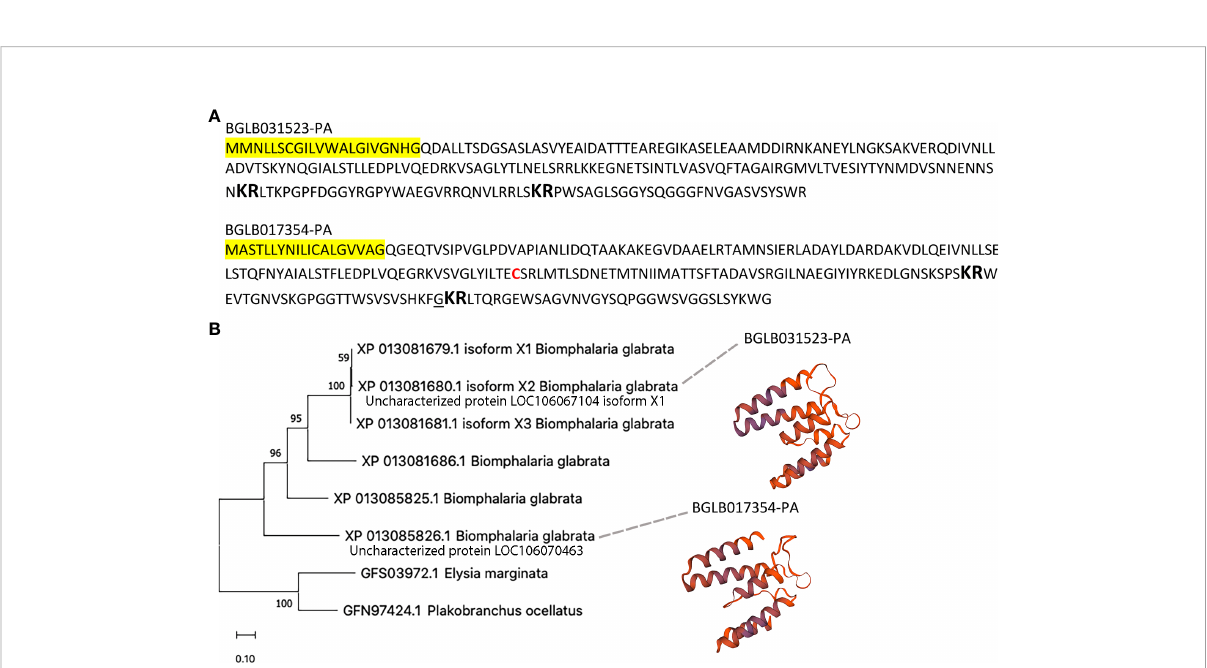
FIGURE 4 Characterisation of S. mansoni attractant candidates uncharacterised proteins LOC106067104 isoform X1 and LOC106070463. (A) Annotation of protein sequences, including signal peptide (yellow highlight), dibasic cleavage sites (large bold), cysteine residue (red font) and amidation (underline). (B) Phylogenetic analysis and protein